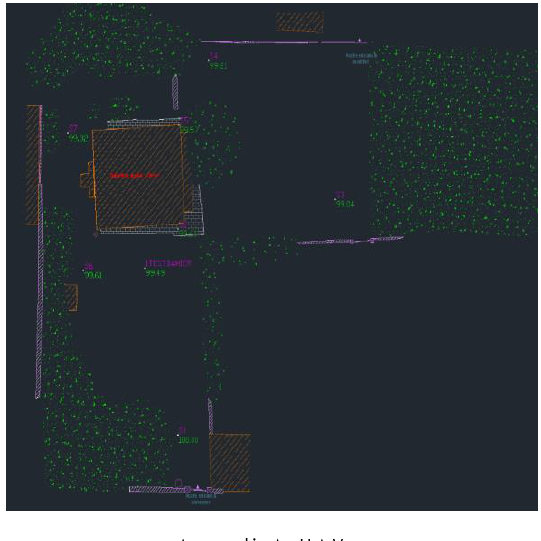
Reconstructions